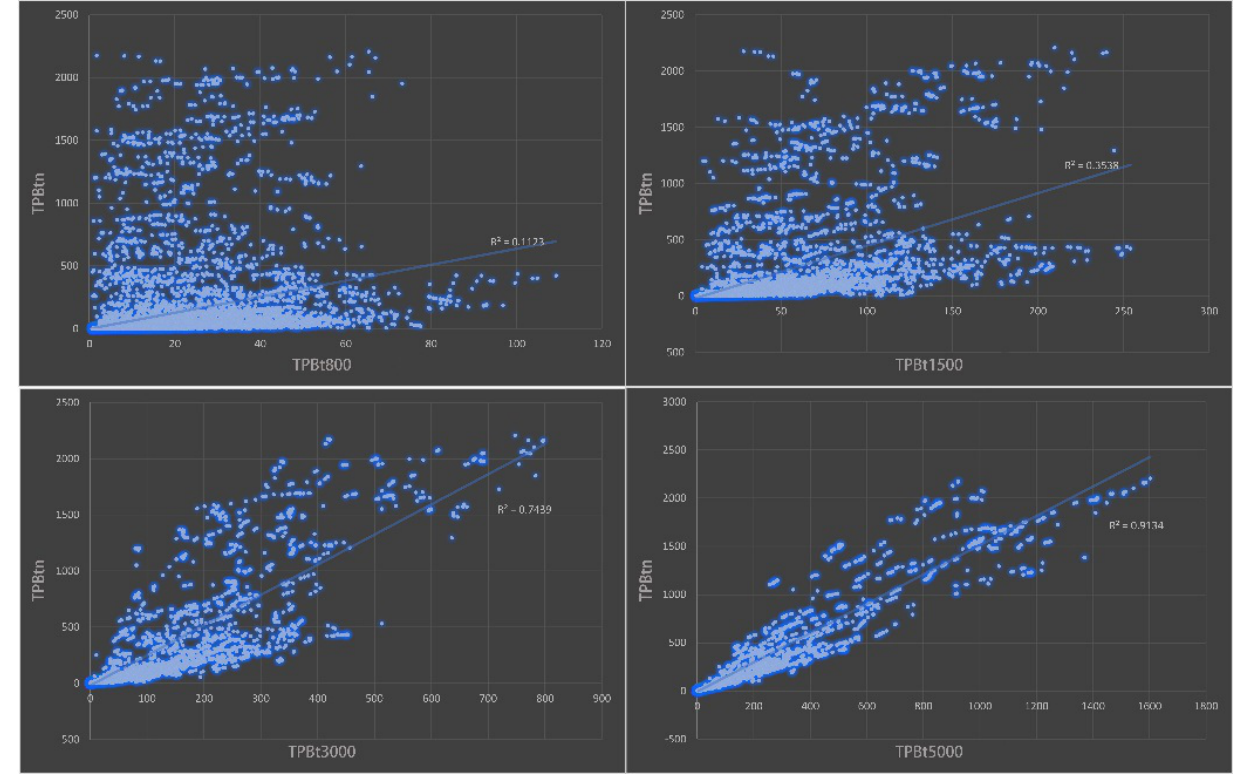
Fig. 25 Analysis of the fitting degree of